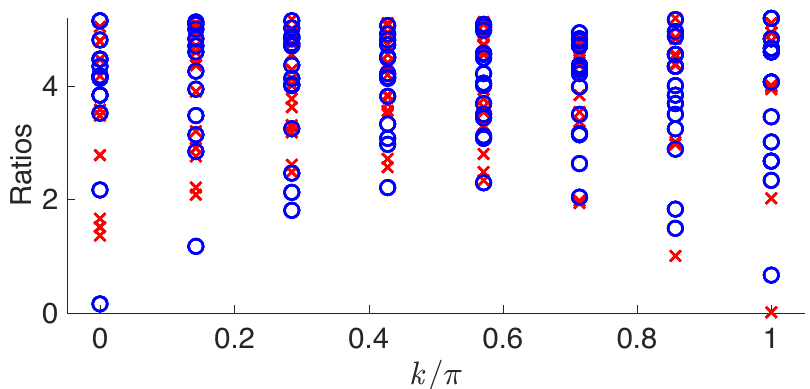
= E = E 0 = E 1 and E for the integrable an- b d c 0 0 for many levels found using exact P operator is one of the lowest-lying crosses at k = 2